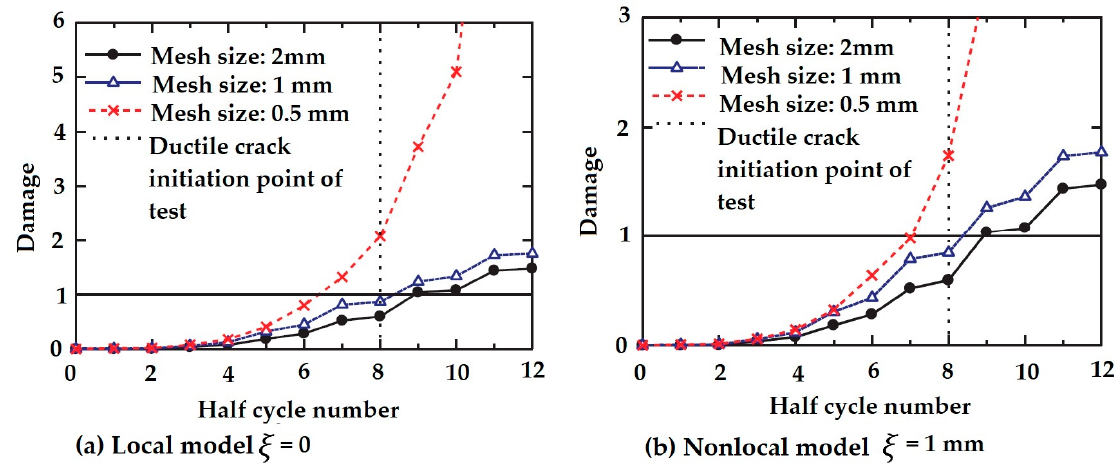
Figure 3. Comparison of local and nonlocal models on damage behaviour [38].